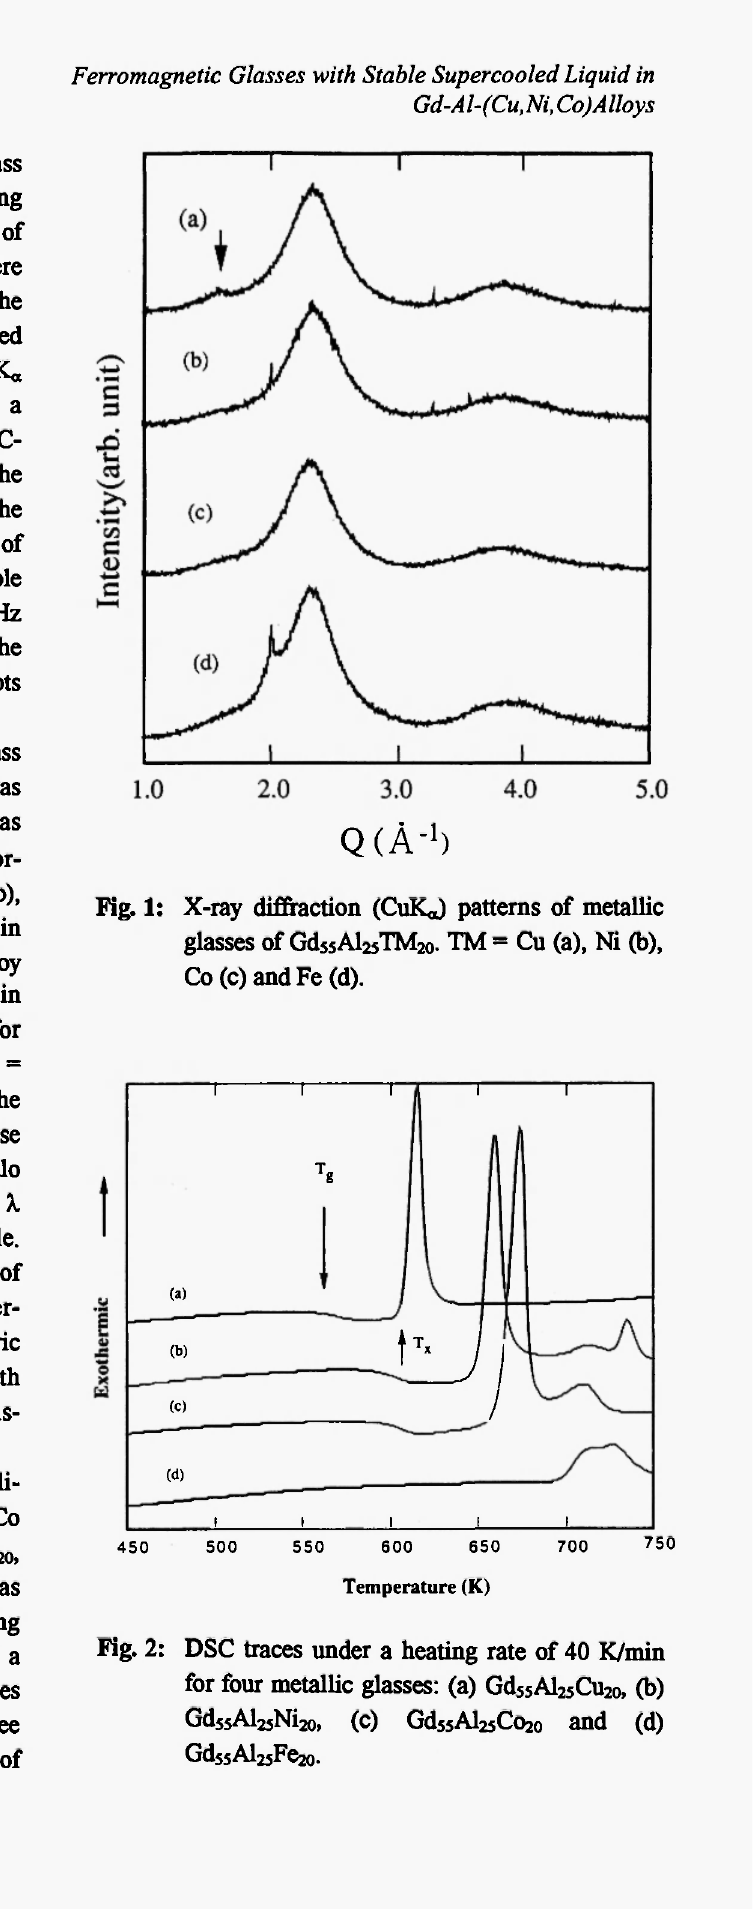
Fig. 2: DSC traces under a heating rate of 40 K/min for four metallic glasses: (a) Gd GdssAlzjNizo, (c) GdssAl^Cozo and (d)